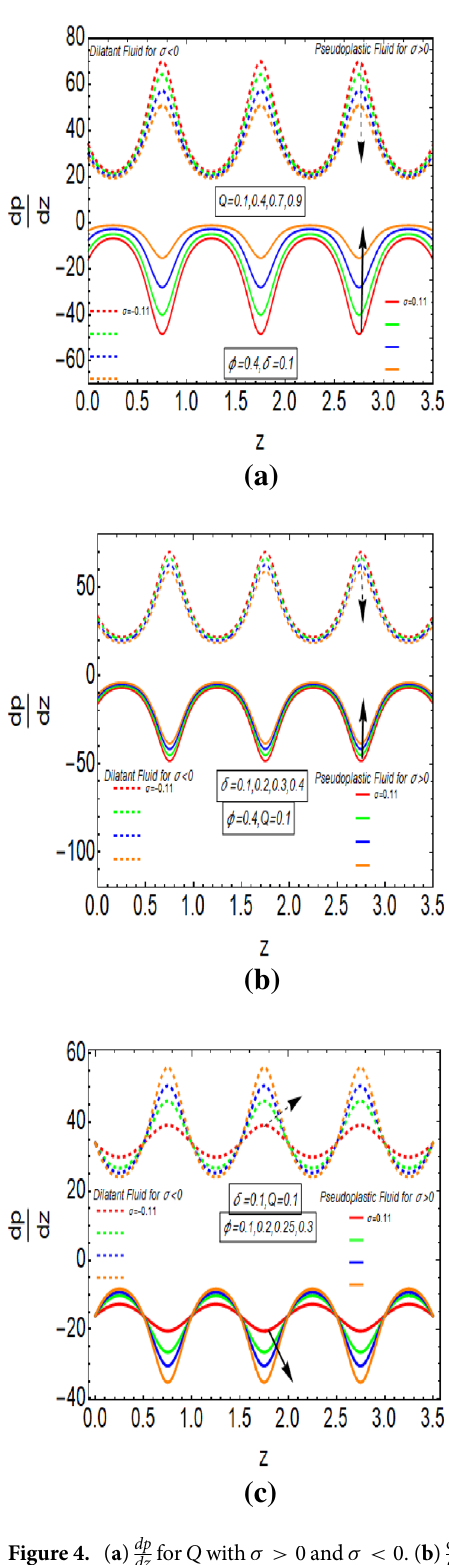
Figure 4. ( a ) dp dz for Q with σ > 0 and σ < 0 . ( b ) dp dz for δ with σ > 0 and σ < 0 . ( c ) dp dz for ϕ with σ > 0 and σ < 0